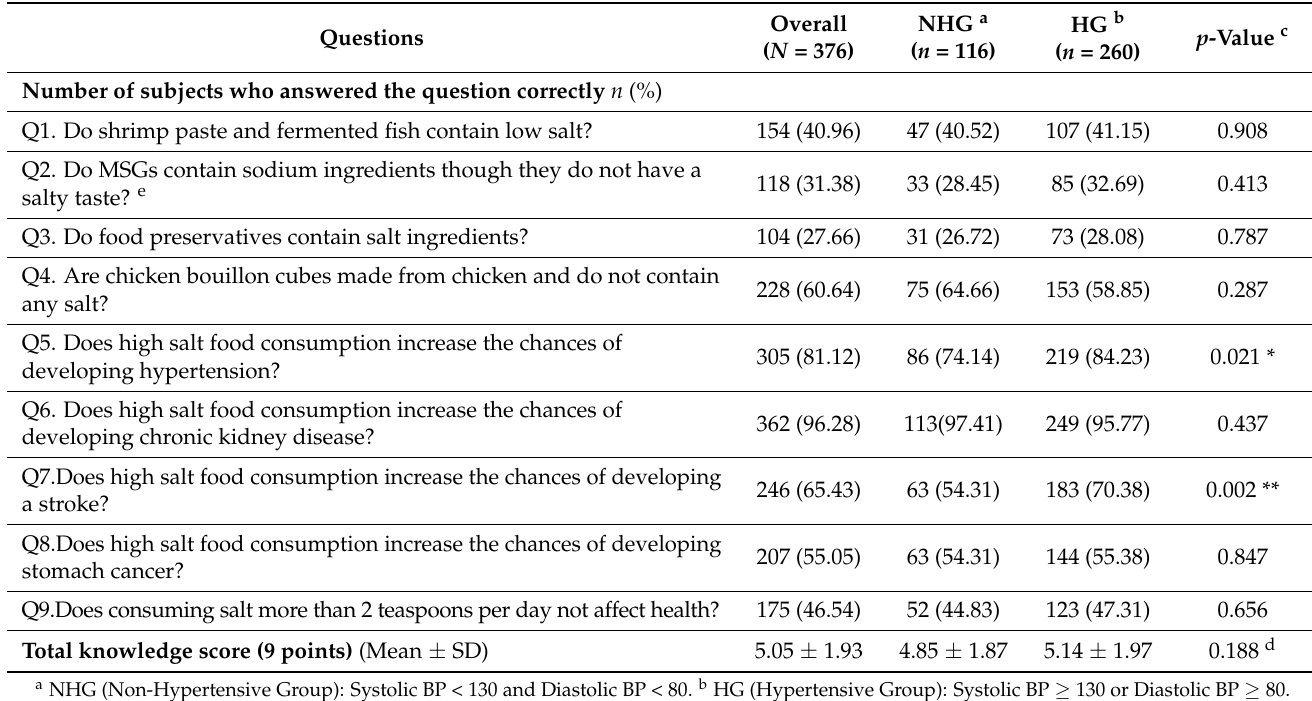
Table 2. Dietary-salt-related knowledge associated with